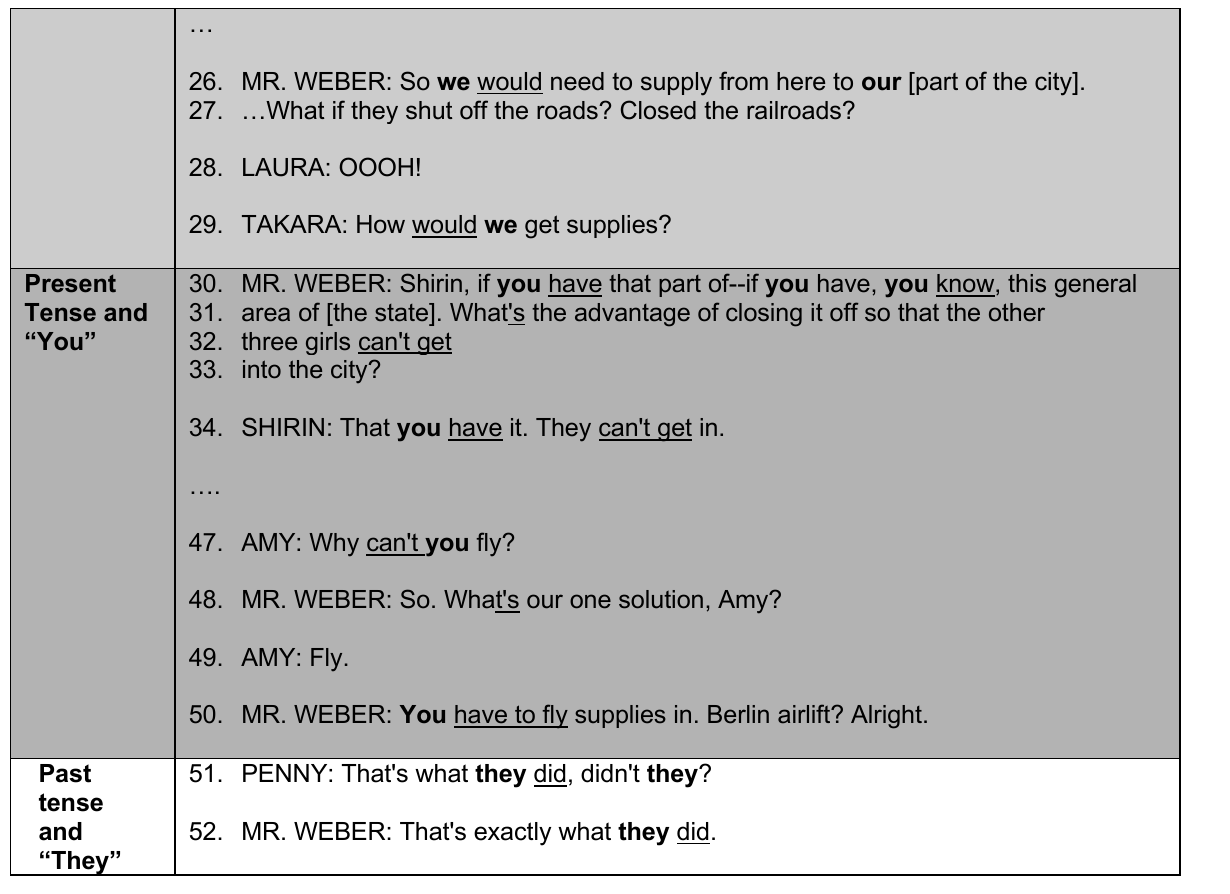
During the explanation of the division of Berlin, a student, Shirin, asked for clarification about why a city that was clearly located in the Eastern (Soviet) half of the country would also need to be divided between East and West (lines 1, 4). In response to Shirin’s question, Weber proposed a “what